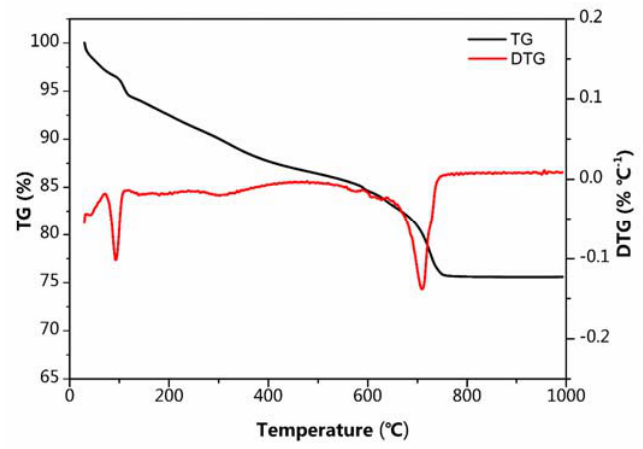
Figure 4. TG-DTG curves of Na 4 Mn 9 O 18 -RGO under an air Figure 4. TG ‐ DTG curves of Na 4 Mn 9 O 18 ‐ RGO under an air atmosphere.